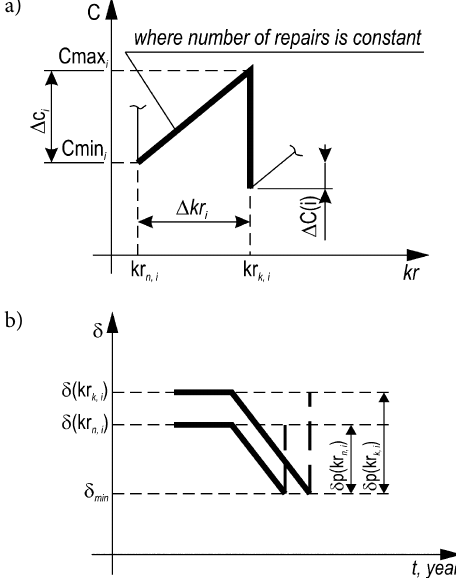
Fig. 5. Cyclically repeated structural units of dependence of repairing cost and repair amount from the reserve coefficient: а – general view of a structural unit of repairing cost dependence from the reserve coefficient dependence; b – cost change (mass, thickness) of repair metal in the limits of one and the same repair amount